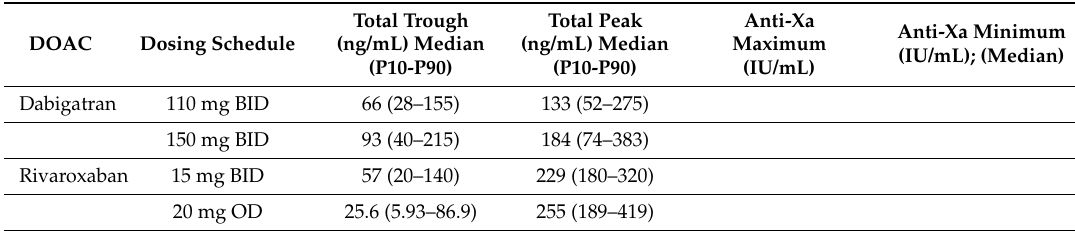
Table 2. Usual observed levels of DOACs depending on the dosage and the time of sampling [12,13], (once daily (OD), twice daily